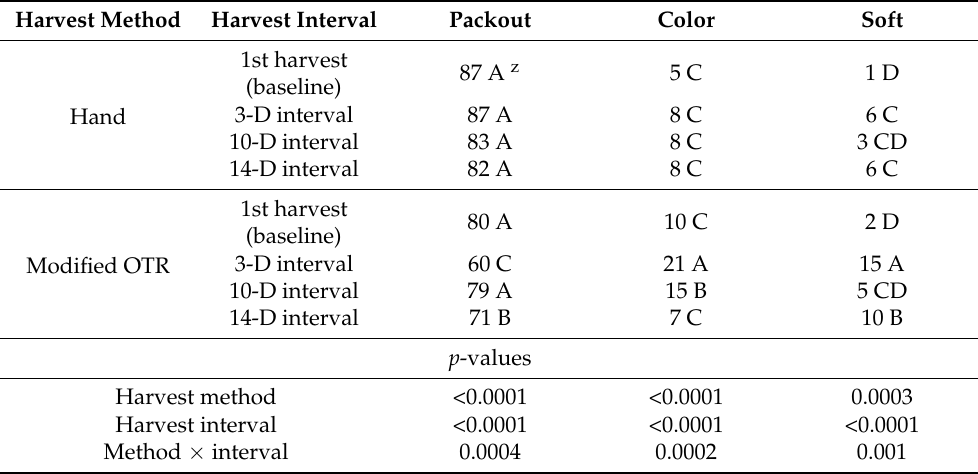
Table 2. Packout, color, and soft defects of ‘Liberty’ northern highbush blueberry in 2019. Fruits were harvested at 3-, 10-, and 14- day harvest intervals by hand or using a modified over-the-row (OTR) harvester with patent-pending elastomeric polymer installed on catching surfaces in northwest Washington. The first harvest was the baseline from which interval treatments were established. Data are reported in